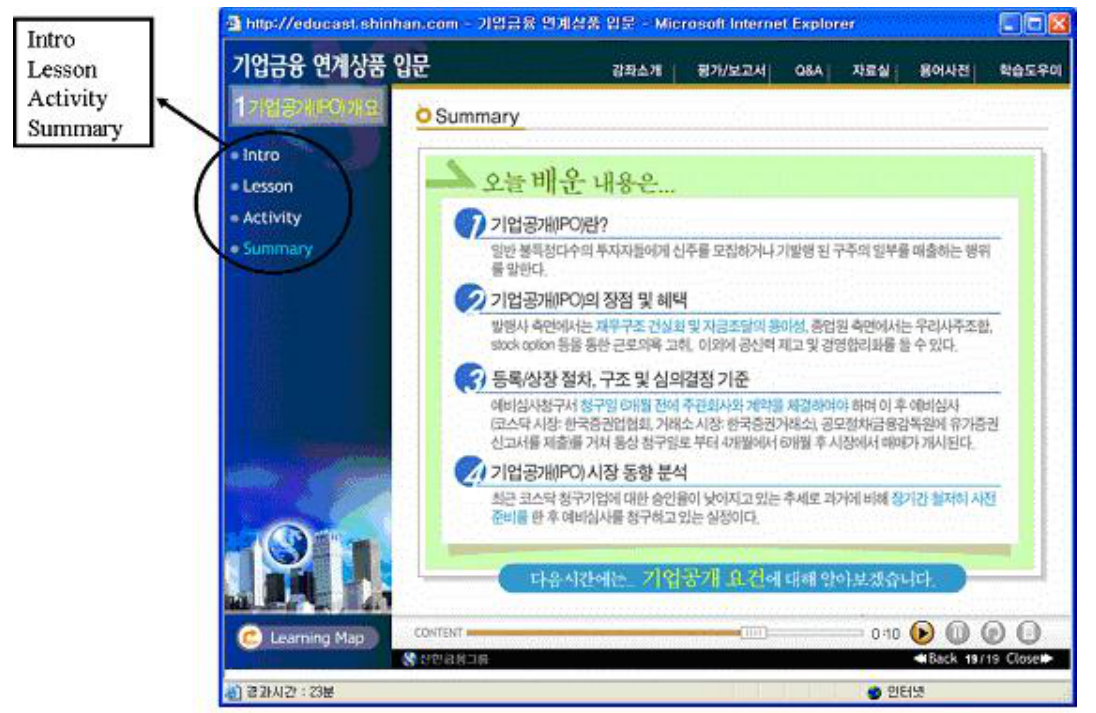
Figure 1. An Example of e-Learning: Tutorial type